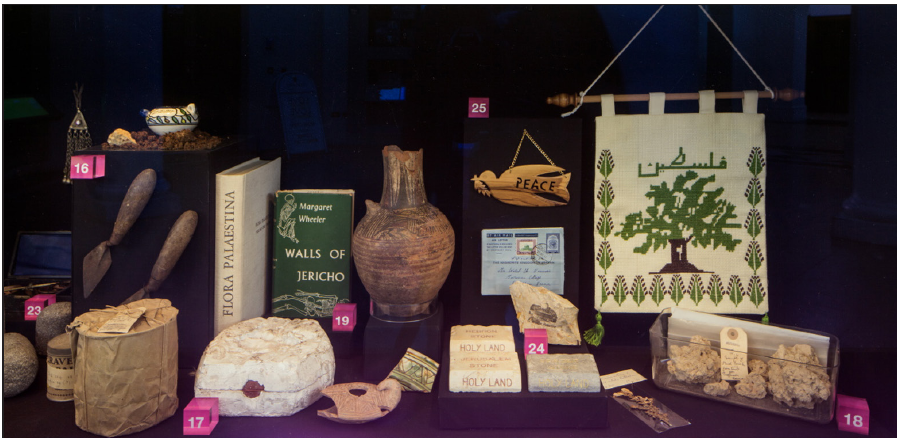
Figure 6: Palestinian material displayed in the Talking Objects case in the Moving Objects exhibition (Photo: Stuart